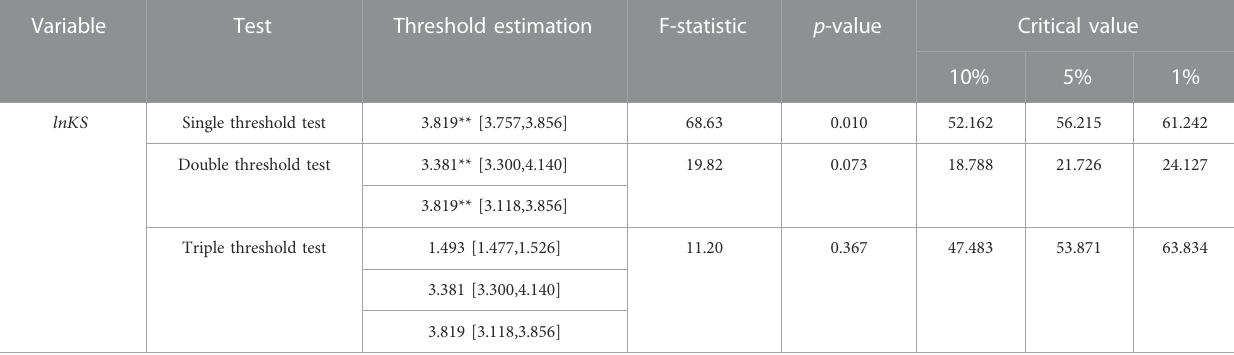
TABLE 7 Threshold effect test. Variable